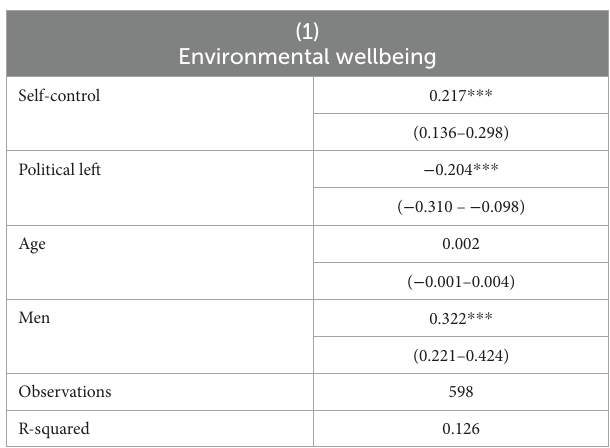
TABLE 5 Environmental wellbeing as a function of self-control, political orientation, and control variables.